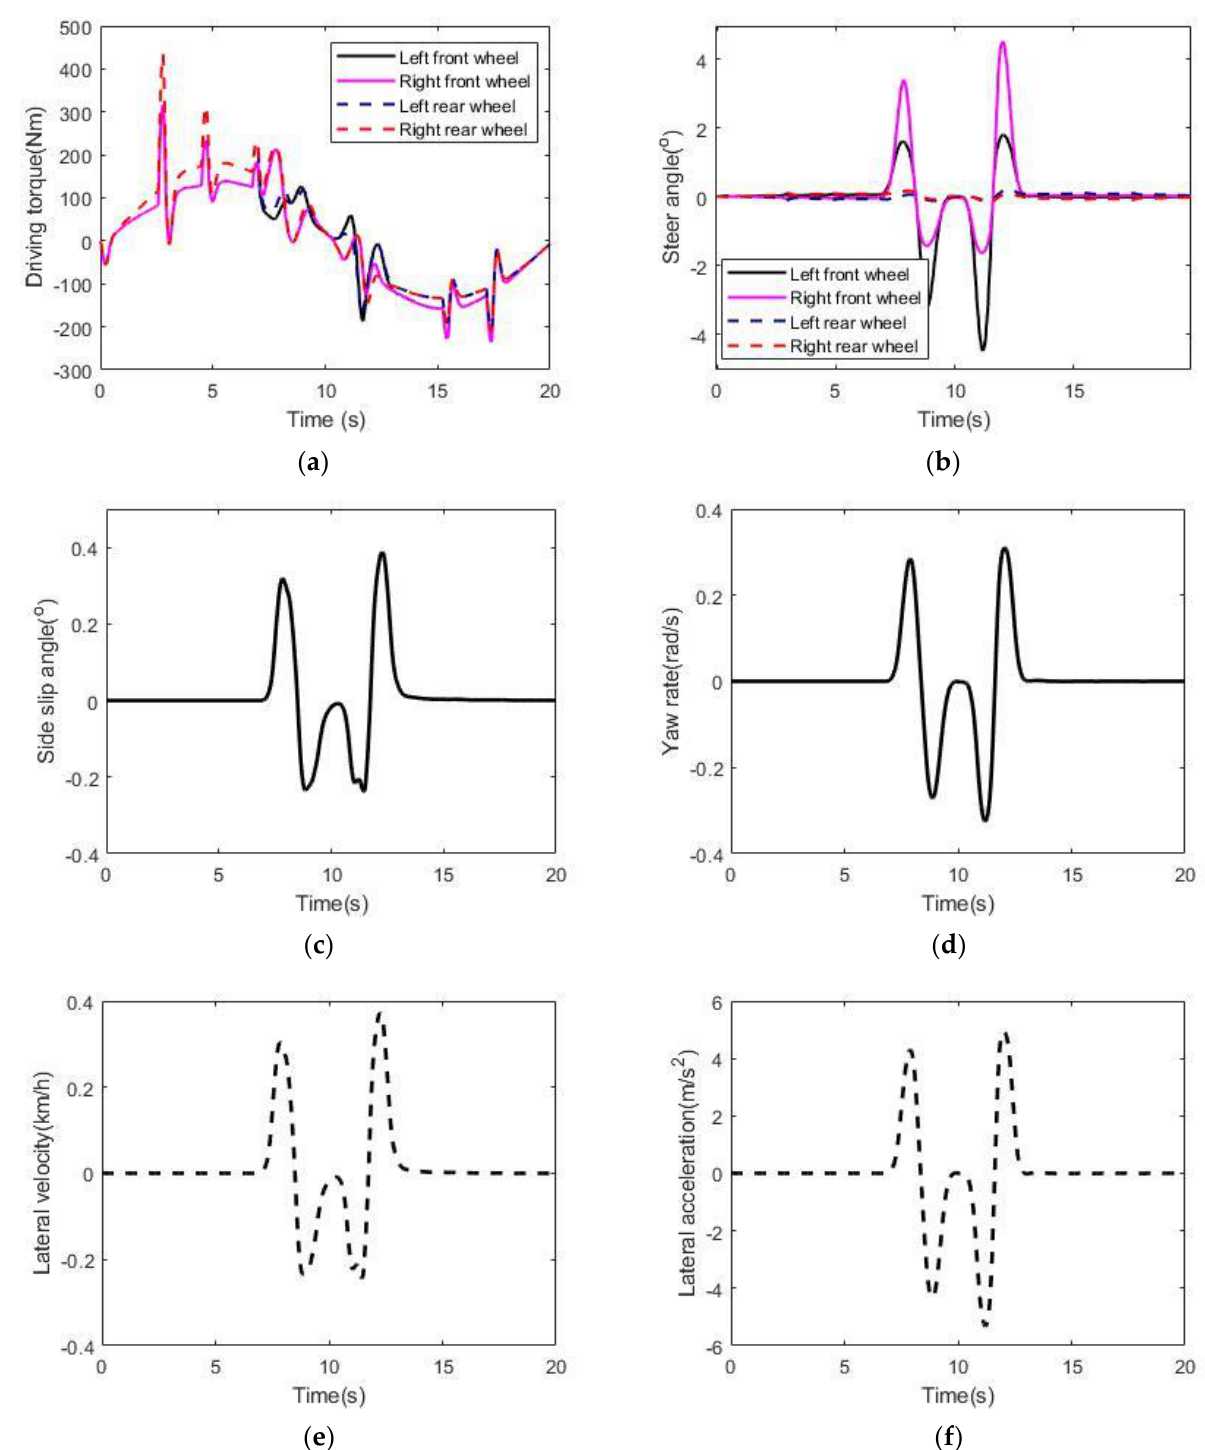
Figure 5. Vehicle state: ( a ) driving torque; ( b ) steer angle; ( c ) side slip angle; ( d ) yaw rate; ( e ) lateral velocity; ( f ) lateral acceleration.